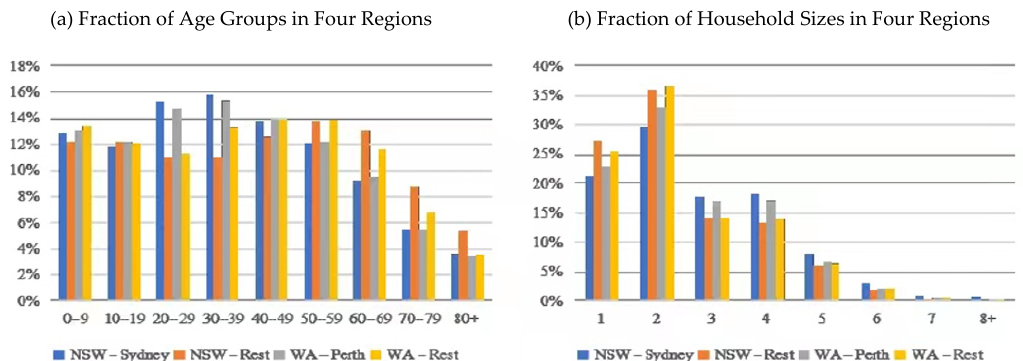
Figure 3. Summaries of age profiles and household sizes in two states: ( a ) age; and ( b ) household size, according to Census 2016 (Australian Bureau of Statistics